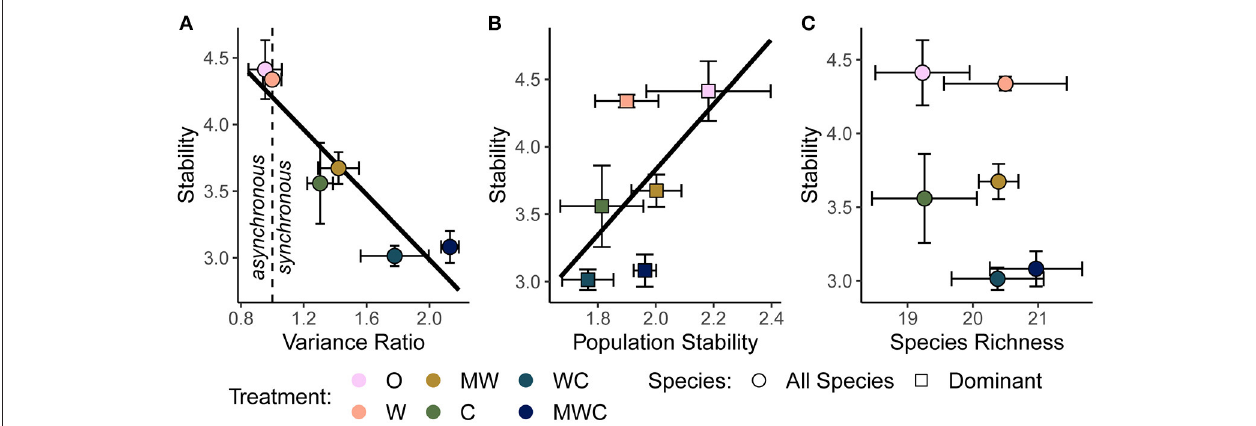
FIGURE 5 | The relationship between stability and the variance ratio (A) , dominant species population stability (B) , and species richness (C) , all calculated over the full timeseries. A variance ratio less than one indicates asynchronous dynamics, and greater than one indicates synchronous dynamics. Black regression lines in (A) and (B) are plotted when the predictor was included in the top model. Figures are based on raw data, but statistical models include random effects to account for spatial and temporal autocorrelation. See Table 4 and Supplementary Table S6 for statistical model details. Herbivore treatments (ordered by total herbivore biomass) are: O, No herbivores; W, Wild mesoherbivores; MW, Wild megaherbivores and wild mesoherbivores; C, Cattle; WC, Wild mesoherbivores and cattle; MWC, Wild megaherbivores, wild mesoherbivores, and cattle.